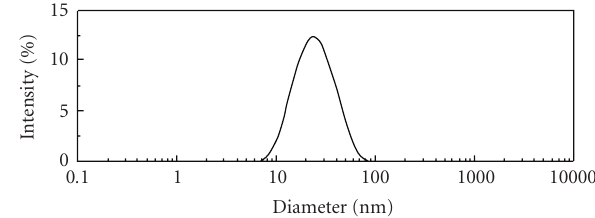
Table 2: COD values of MB solution during the photodegradation progress. Figure 3: Particle size and its distribution of TiO 2 sol.